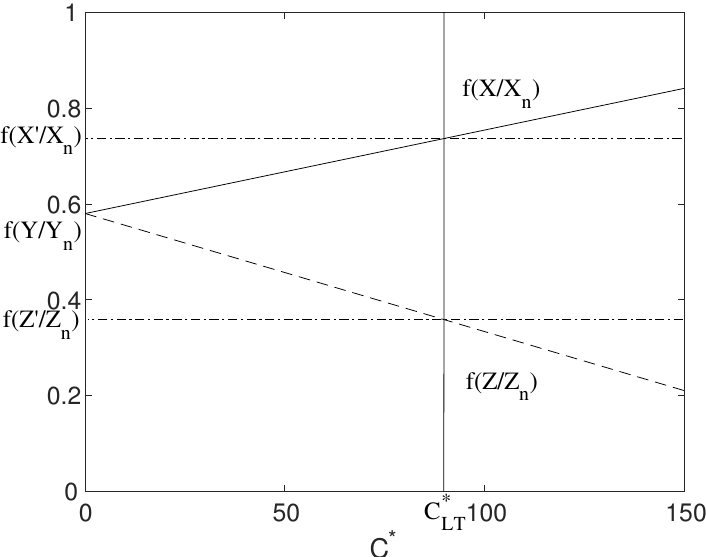
Figure 5. f ( X / X n ) and f ( Z / Z n ) plotted as a function of C ∗ at ( Y = 0.005 + 0.01 ( 20 − 1 ) , h = 0.5 + ( 30 − 1 ) ). In this case, C ∗ is LT